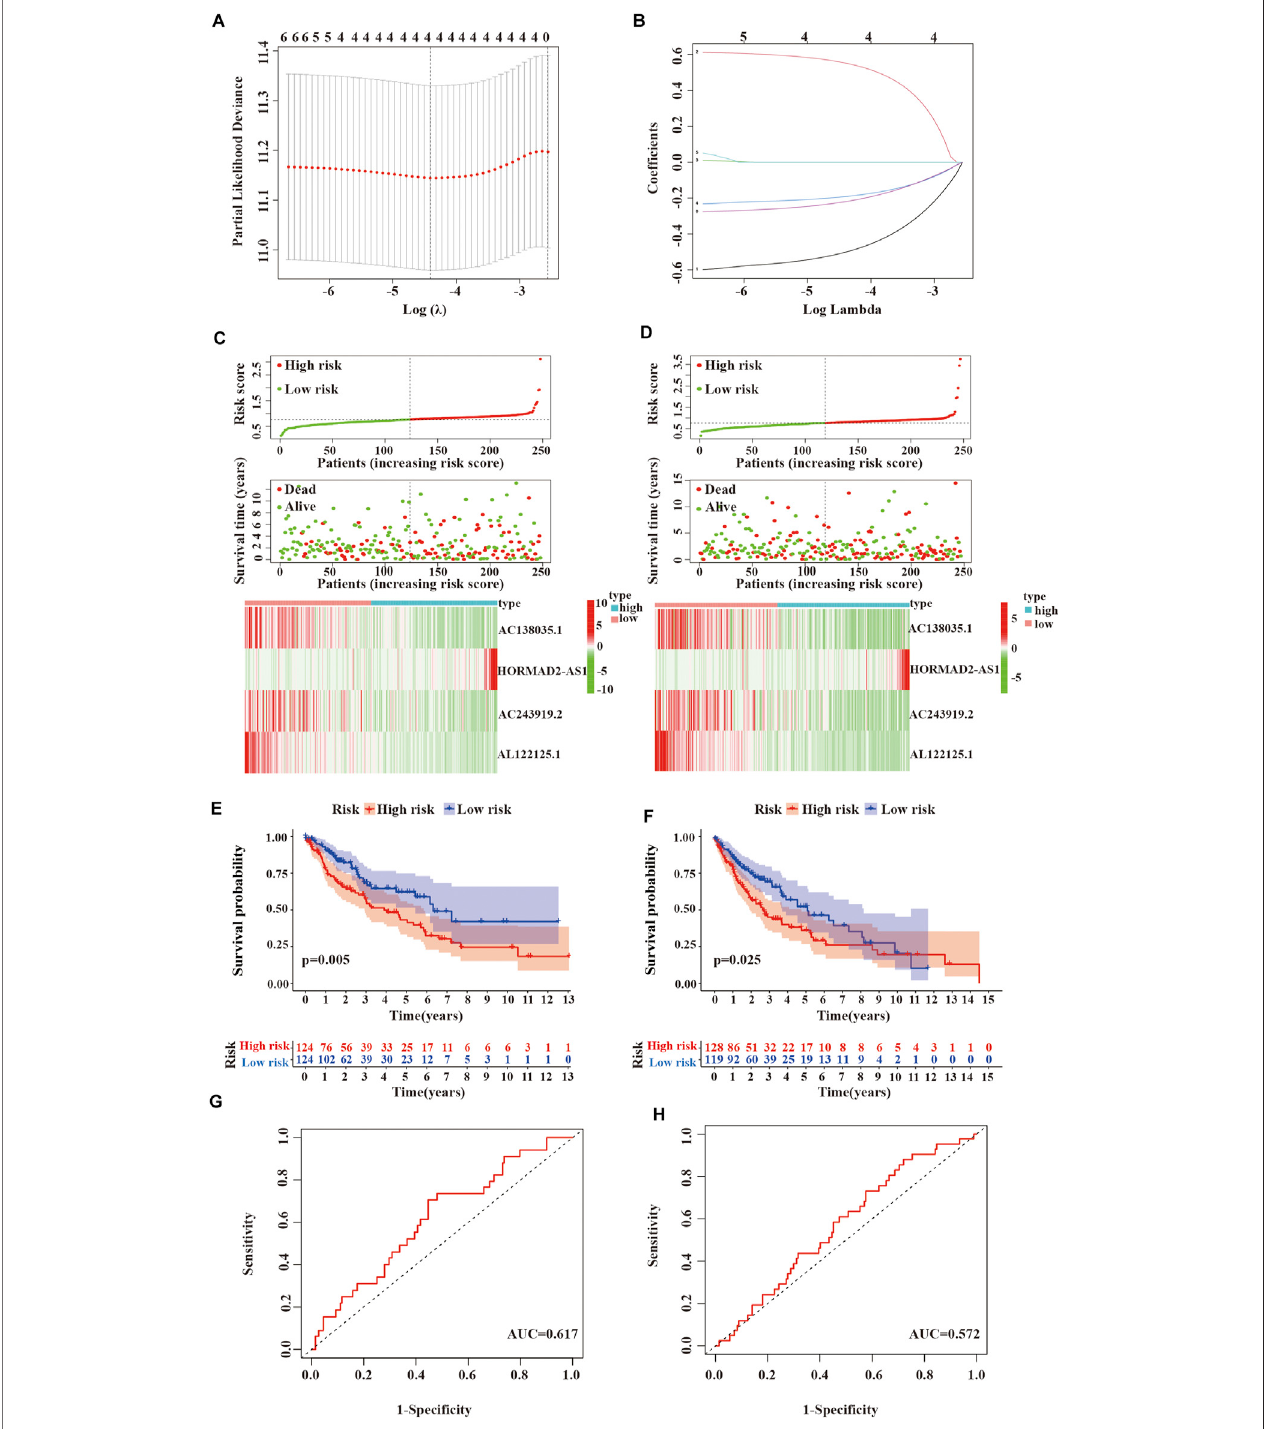
FIGURE 7 | Verifying the risk model. (A,B) LASSO Cox regression analysis of 6 m 6 A-related lncRNAs with prognostic value. (C) Survival status and expressive heatmap of 4 m 6 A-LPMs in the training group (red indicates high expression, green indicates low expression). (D) Survival status and expressive heatmap of 4m 6 A-LPMsinthetestgroup(redindicateshighexpression, greenindicateslowexpression). (E,F) Kaplan-Meier curveof4m 6 A-LPMsinthetraininggroup (E) andtest group (F) . (G,H) time-ROC curves of 4 m 6 A-LPMs in the training group (G) and test group (H) . LASSO, the least absolute shrinkage and selection operator; ROC, the receiver operating characteristic curve; m 6 A-LPMs, m 6 A-related lncRNA prognostic markers. Statistical methods: Chi-square test, log-rank test.